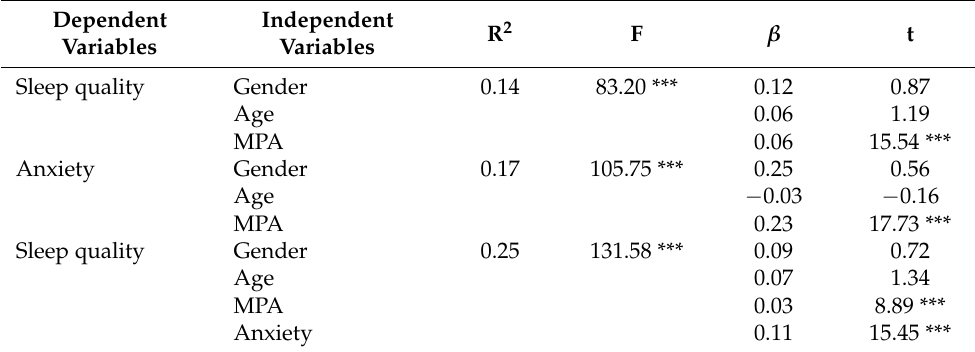
Table 2. Regression analysis of the mediating effect of anxiety in the relationship between MPA and sleep quality.